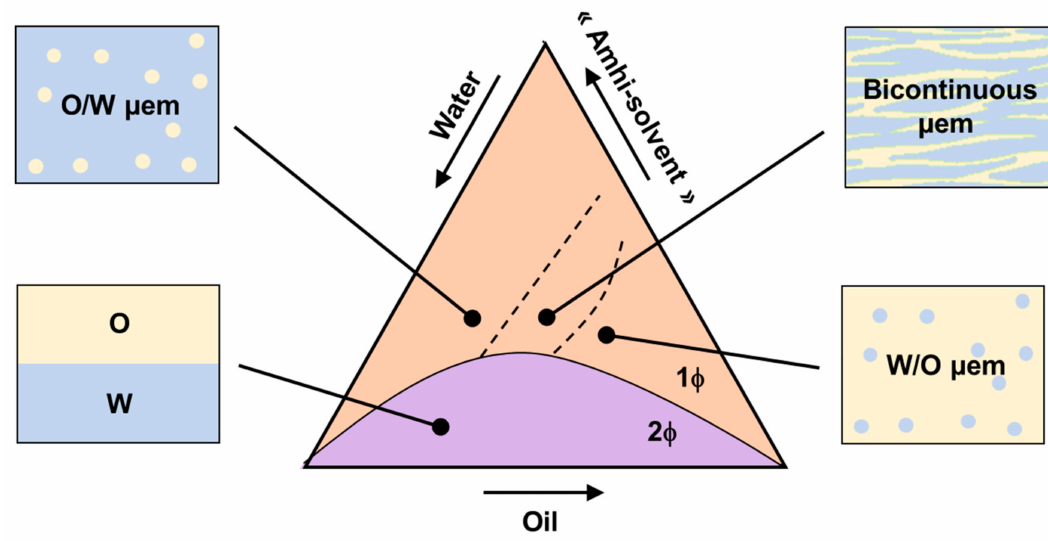
Figure 35. A schematic phase diagram of an “amphi-solvent”/water/oil ternary system and surfactant-free microemulsion